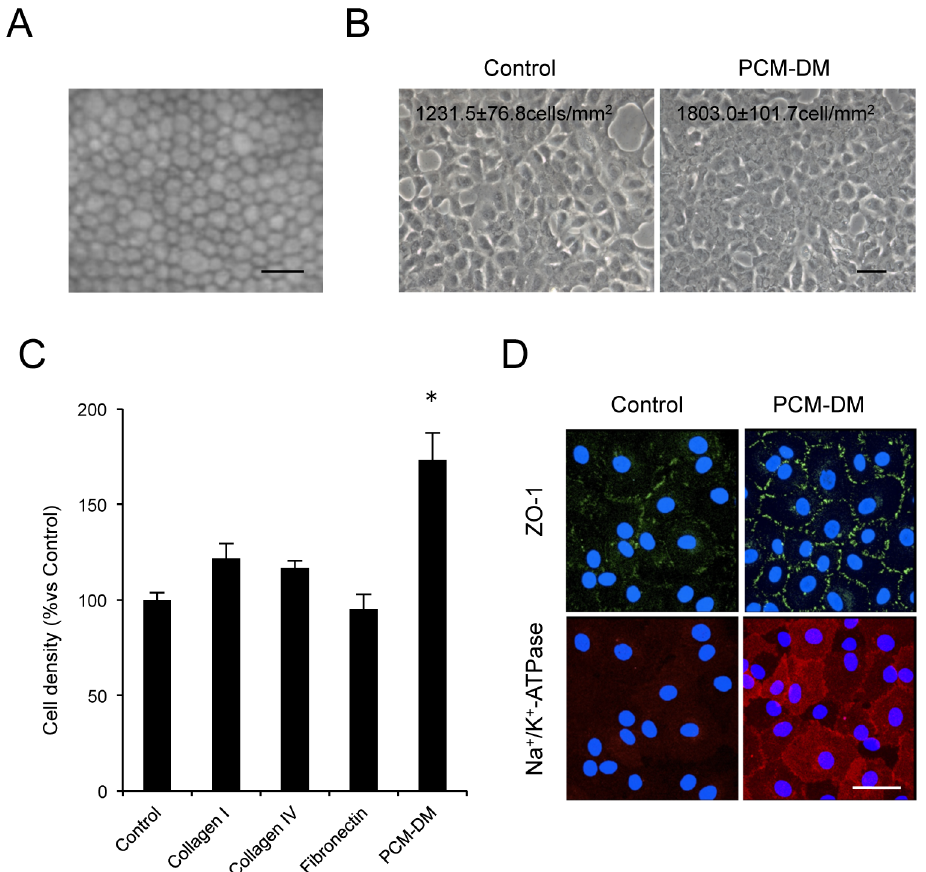
Figure 5. Characteristics of cultivated HCECs on PCM-DM. (A) An image of corneal endothelium of a normal human subject was obtained by in vivo contact specular microscopy. Scale bar: 100 m m. (B) The HCECs (passage 3) were passaged on the PCM-DM and on the control culture dish and cultured for 30 days to form a monolayer sheet. Representative phase contrast images are shown. Scale bar 100 m m. The experiments were performed in triplicate. (C) The HCECs were passaged on the noncoated plate (control), collagen 1, collagen 4, fibronectin, and PCM-DM and cultured for 30 days. The cell densities of the HCECs were evaluated by KSS-400EB software. The experiments were performed in triplicate. (D) ZO-1 and Na + / K + -ATPase at the plasma membrane was stained in the HCEC culture on the PCM-DM and on the control culture plate. Scale bar 50 m